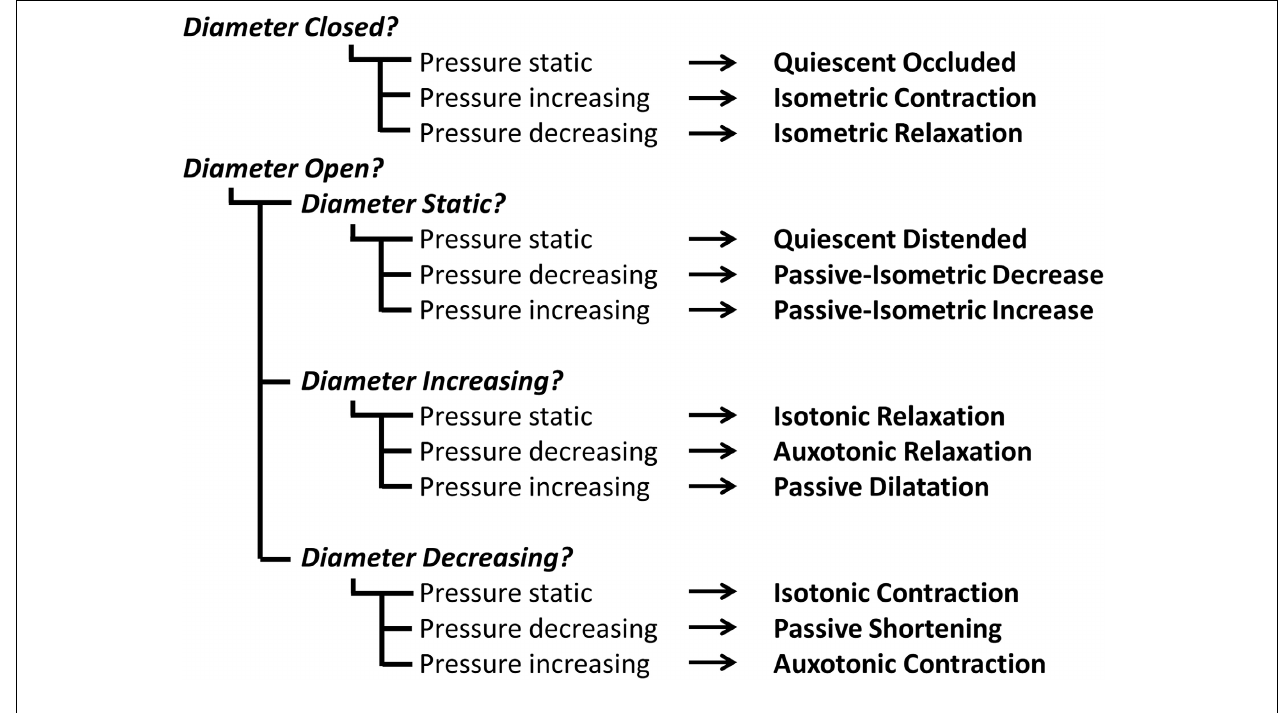
FIGURE 6 | Decision tree applied to define UES mechanical states.